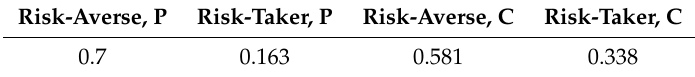
Table 4. Proportions c played for our risk-based cognitive models in Game